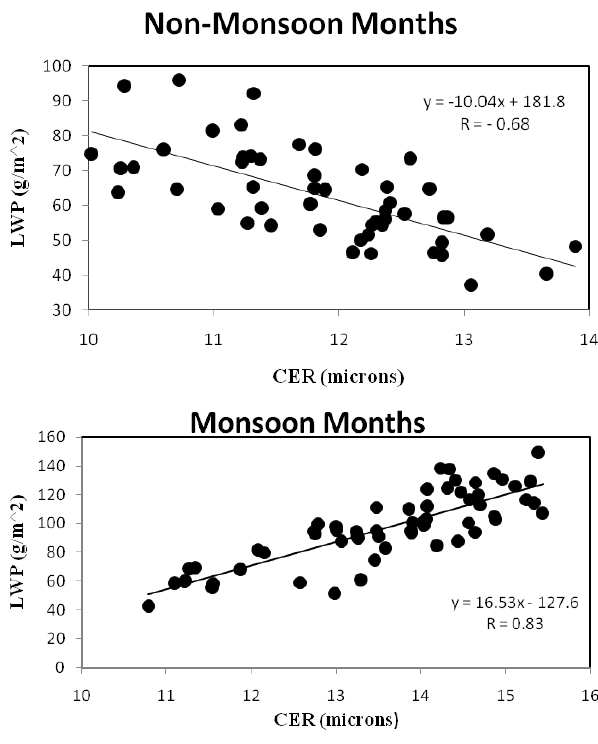
Fig. 4 Scatter diagram between LWP and CER for (a) non-monsoon months and (b) monsoon months This result is in accordance with the observations made by Rosenfeld et al. (1999) and Ferek et al. (2000) in which they show that smaller CER lead to an increase in LWP suppressing drizzle formation in smoke plumes and ship tracks. The suppression of drizzle enhances cooling below the cloud base because smaller droplets evaporate more quickly. This cooling acts along with the radiative heating of the cloud base to suppress turbulent mixing, de-coupling the cloud from the rest of the boundary layer restricting the supply of water vapour. This reduction in water vapour